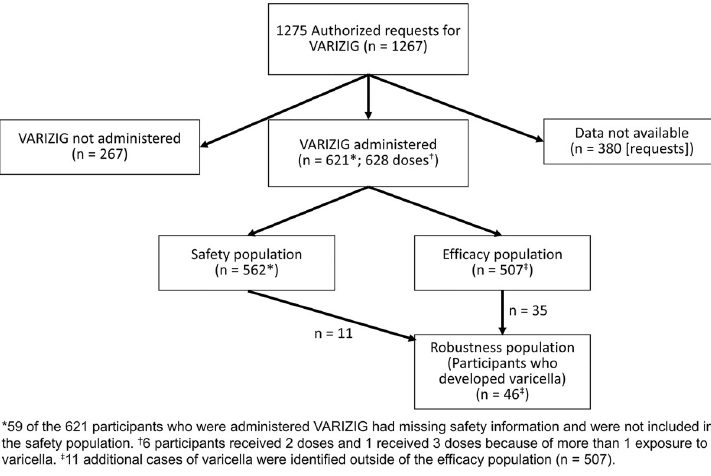
Fig 1. Participant